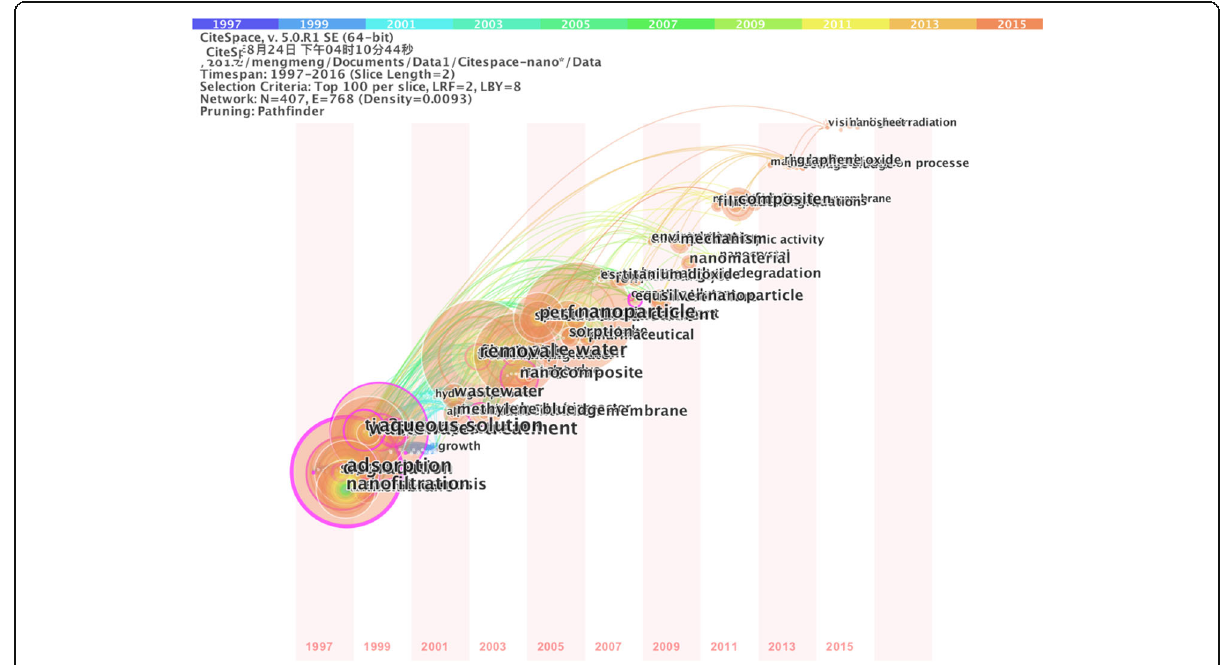
Fig. 4 Timeline view of a network related to co-occurring